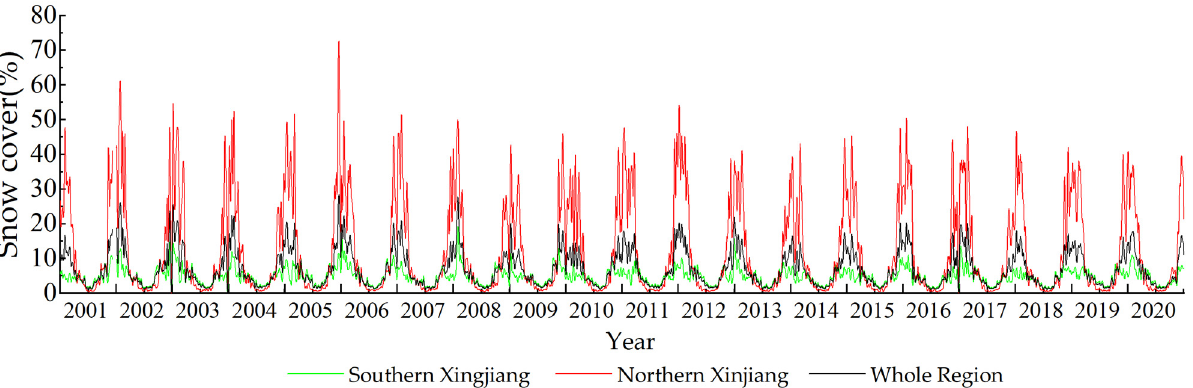
Figure 4. Interannual change of the snow cover fraction of Xinjiang (includes northern region and southern region) from 2001 to 2020.